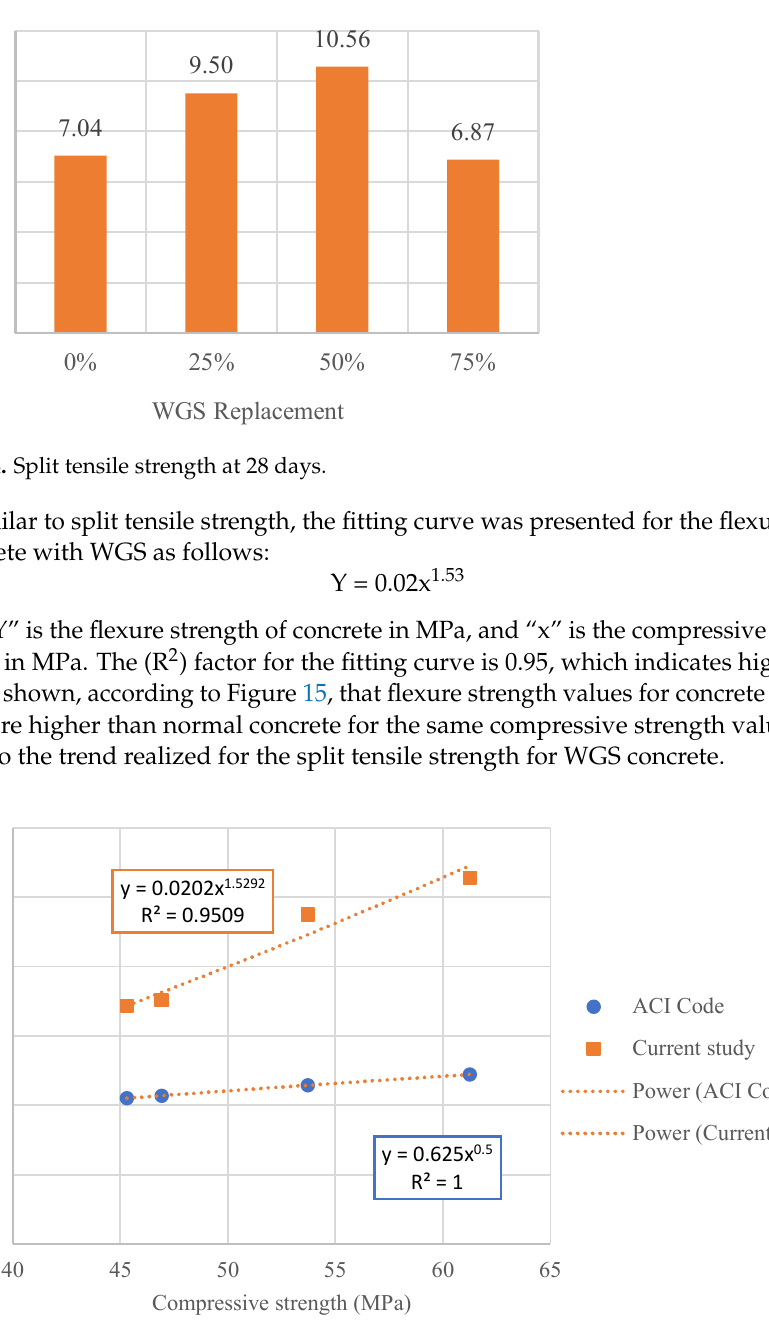
11 of 16 Figure 13. Fitting curve for the split tensile strength compared to ACI code equation. 3.7. Flexure Strength The flexural strength results presented in Figure 14 showed that specimens with 50% glass sand replacement showed the highest flexural strength of 10.56 MPa. This is 50% higher than the flexure strength of the control specimen. As the replacement percentage went beyond 50%, the flexure strength showed a significant reduction. This lies within the range of several previous studies conducted on concrete with WGS [1,22]. However, some other studies indicated a reduction in flexure strength as the percentage of WGS increased due to the high porosity of concrete incorporating WGS [35]. Similar to split tensile strength, the fitting curve was presented for the flexure strength of concrete with WGS as follows: Y = 0.02x 1.53 (3) where “Y” is the flexure strength of concrete in MPa, and “x” is the compressive strength